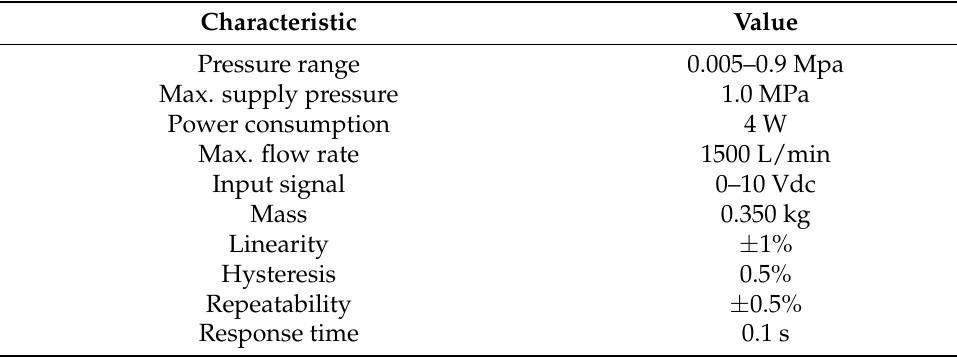
Table 1. Electropneumatic Regulator ITV2050